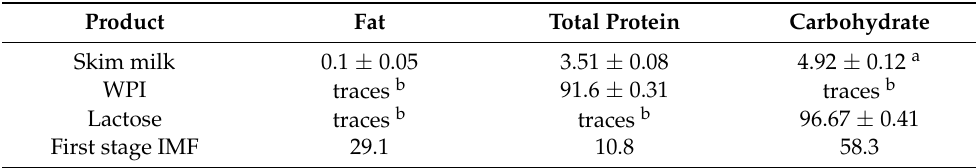
Table 1. Macro-nutrients content of ingredients and the first stage infant milk formula (IMF) expressed as g per 100 g